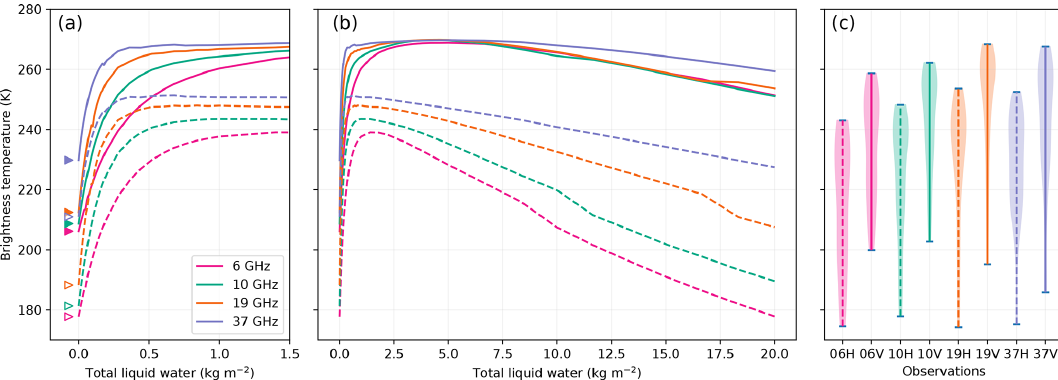
Figure 5. Brightness temperatures at Roi Baudouin as a function of the total liquid water content in the top 10cm of the snowpack for four frequencies and at V-pol (solid curves) and H-pol (dashed curves) ( a , zoomed in; b , full range). The simulated dry brightness temperatures are marked by the triangles. The seasonal air temperature is set to 273K, which explains why the dry brightness temperatures are higher than in Fig. 3 where the winter seasonal temperature was used. Distribution of observed satellite brightness temperatures only for the days when the surface is melting (based on the melt rates computed from in situ measurements by Jakobs et al., 2020) (c) .